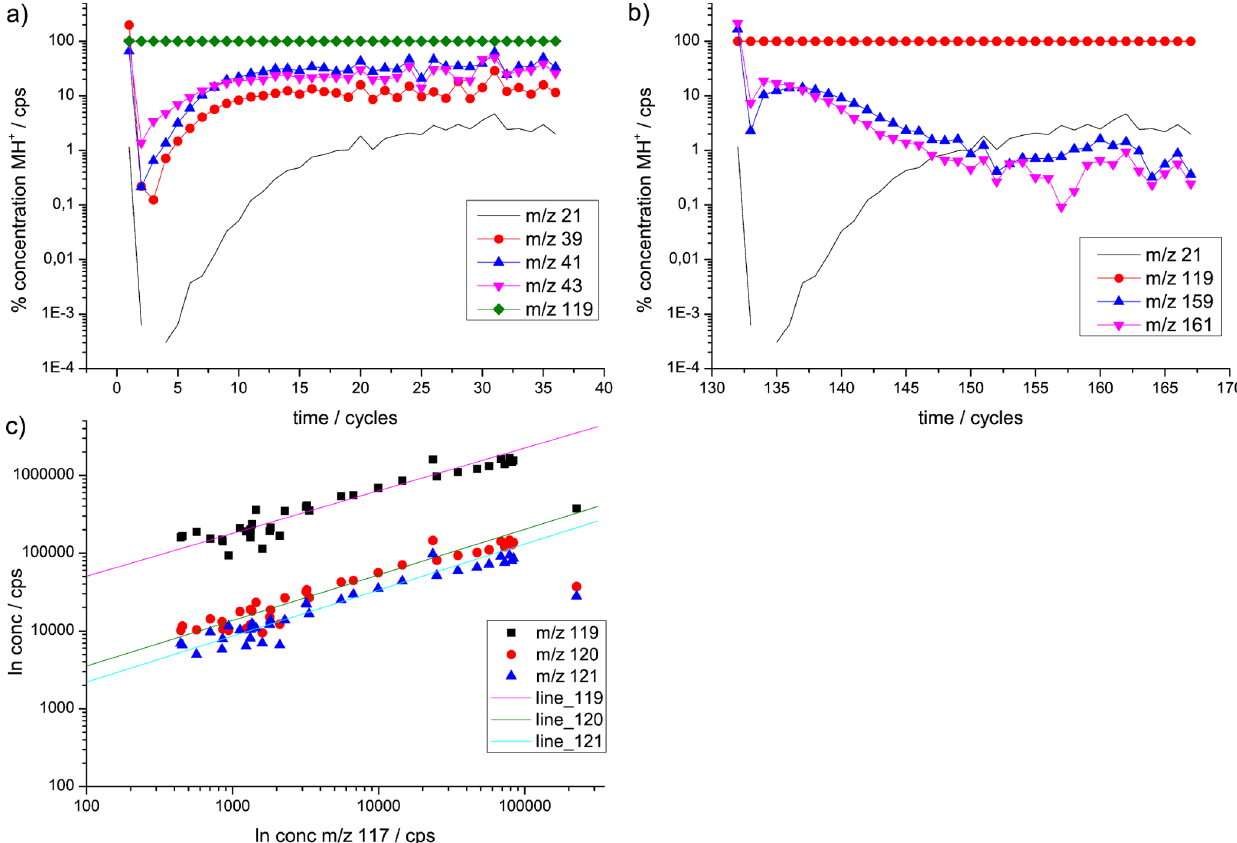
N Figure 3. Details for DPS in PIDK. a) Signals m/z 39, 41 and 43– typically carbon chain fragments. Demonstration of the slightly different ) and 41 ( m ) in PIDK. m/z 43 is a suspected precursor ion for m/z 39 and m/z 41, all of which are behavior of m/z 43 ( . ) compared to m/z 39 ( N typically carbon chain fragments. The signals are normalized to 100% MH + at m/z 119 ( ¤ ). b) Signals m/z 159 and m/z 161– typically adduct ). Adduct ions ions. Demonstration of the behavior of m/z 159 ( m ) and m/z 161( . ) in PIDK. The signals are normalized to 100% MH + at m/z 119 ( here are supposed to be the result of two (or more) molecule (M) parts. m/z 161 and m/z 159 probably are R-S-R ? R ? H + and [R-S-R ? R-H 2 ] ? H + , respectively. c) DMS isotopologue ratios. Demonstration of the deviations from the expected isotopologue ratios. The MH + of DMS is 63, and the iotopolouges are m/z 64 and 65. Plot of log concentration (conc) m/z 61 versus log concentration of m/z 63, log m/z 64 and log m/z 65, demonstrating the correct isotopologue ratio and deviation therefrom because of changes in the ratio. Deviations are explained as results from dehydrogenation reactions. m/z 117 was chosen as x-axis as it is the result solely of dehydrogenation from m/z 119 to [MH + - H 2 ]. Other signals at various m/z are the results of a combination of isotopologues of m/z 119 and dehydrogenation reactions. The parallel diagonal lines are intended as help to guide the eye. doi:10.1371/journal.pone.0066925.g003 PLOS ONE |